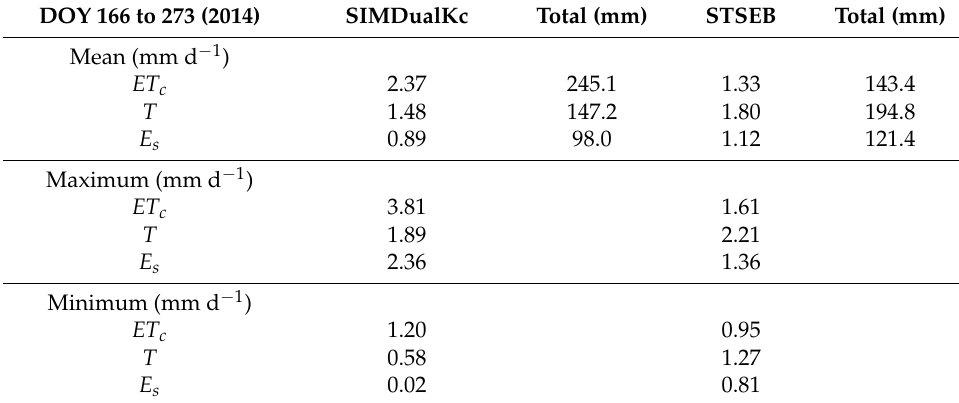
Table 6. Total, mean, maximum, and minimum actual evapotranspiration ( ET c ), transpiration (T), and soil evaporation ( E s ) simulated with the SIMDualKc and STSEB models in the year 2014 during the period DOY 166 to